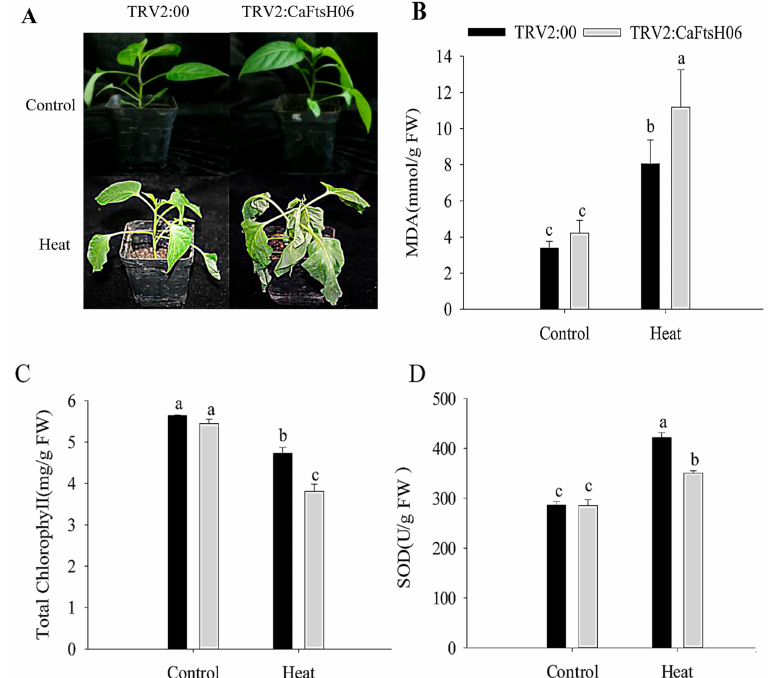
Figure 6. Analysis of heat tolerance of CaFtsH06 -silenced pepper. ( A ) Phenotype identification of pTRV2:00 and pTRV2: CaFtsH06 -silenced plants after heat treatment. ( B ) The malondialdehyde (MDA) content of plants after heat stress. ( C ) Total chlorophyll content of plants after heat stress. ( D ) The SOD content of plants after heat stress. Different letters denote statistical significance ( p <